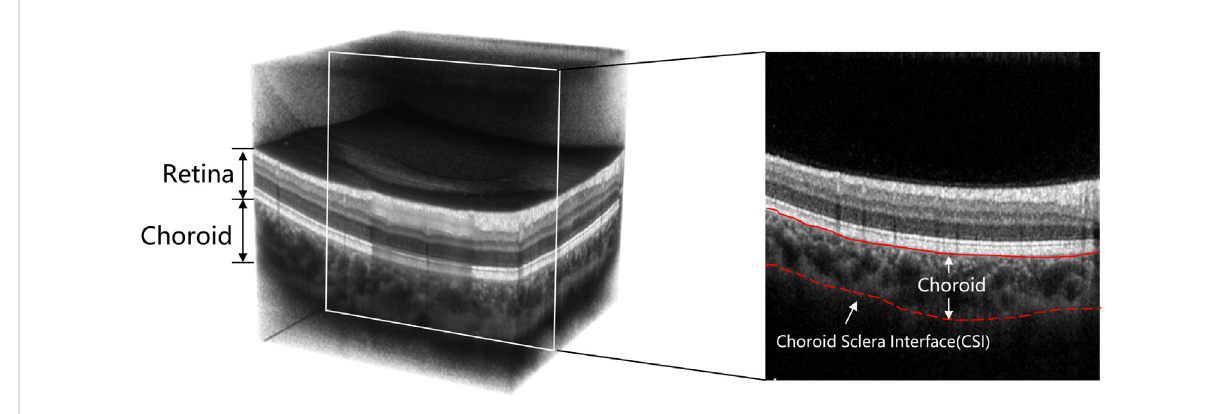
FIGURE 1 Examples of a 3D OCT volume and 2D OCT B-scan image. The choroid-sclera interface (indicated by the red dashed line) is ambiguous and dif fi cult to extract compared to the other boundaries.